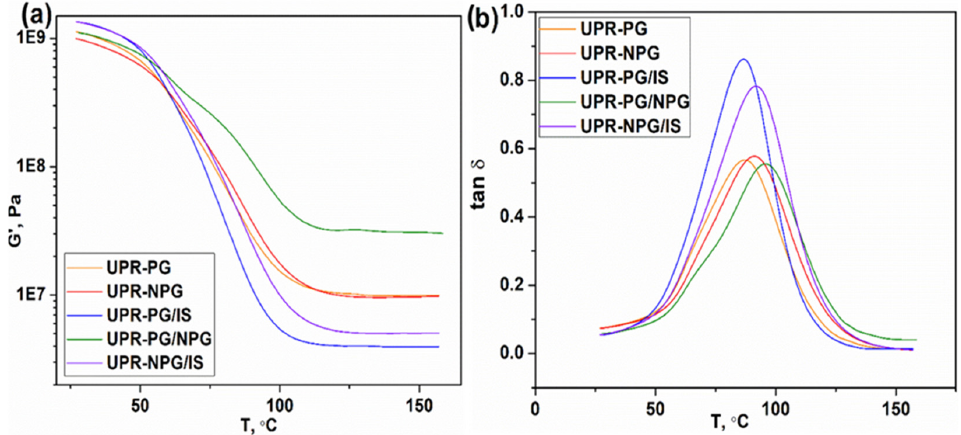
Figure 5. DMA curves of the storage modulus, G ′ ( a ) and loss factor, tan δ ( b ) of the prepared UPRs at a fixed strain amplitude of 0.1% and a single angular frequency of 1 Hz.